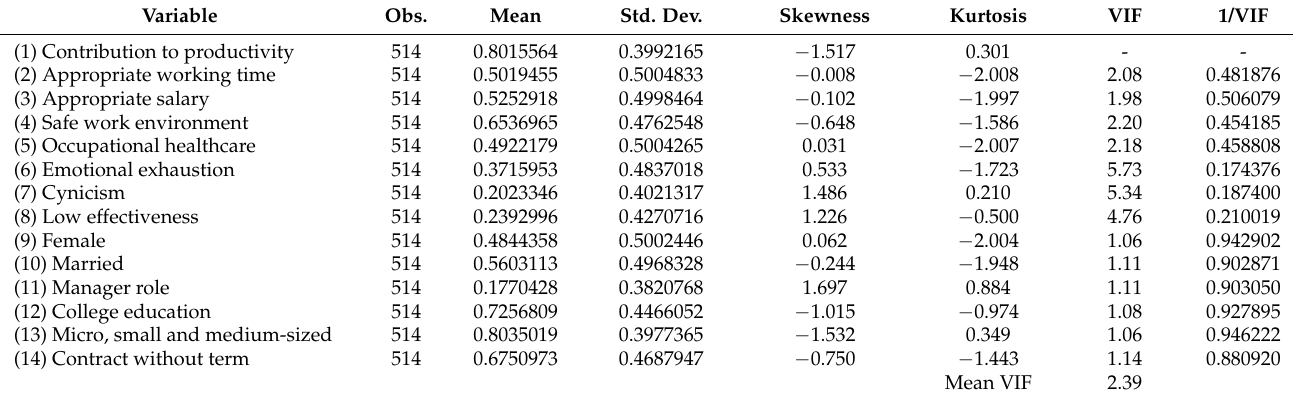
Table 2. Descriptive statistics and variance inflation